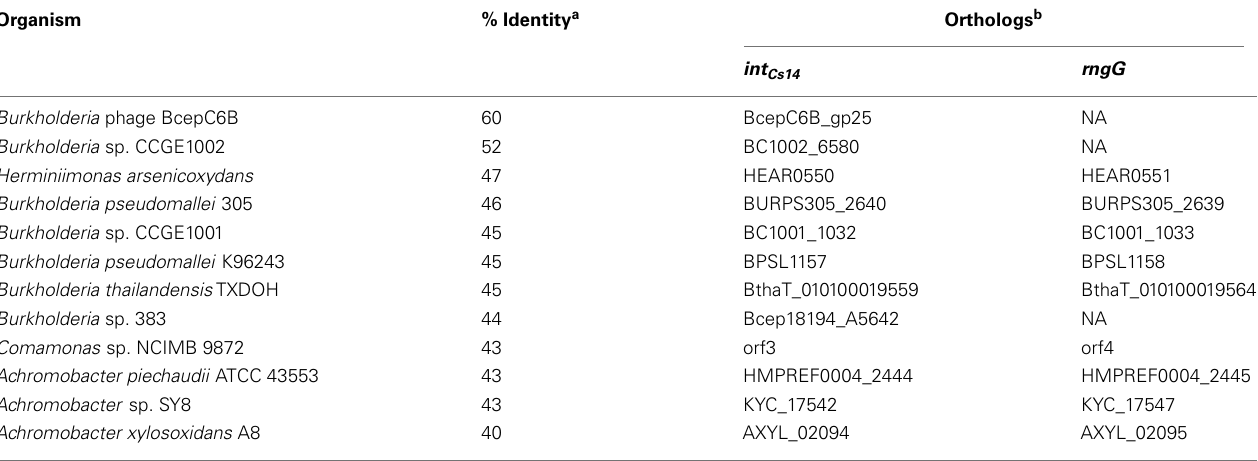
Table 3 | Orthologs of int Cs 14 and adjoining rngG genes.